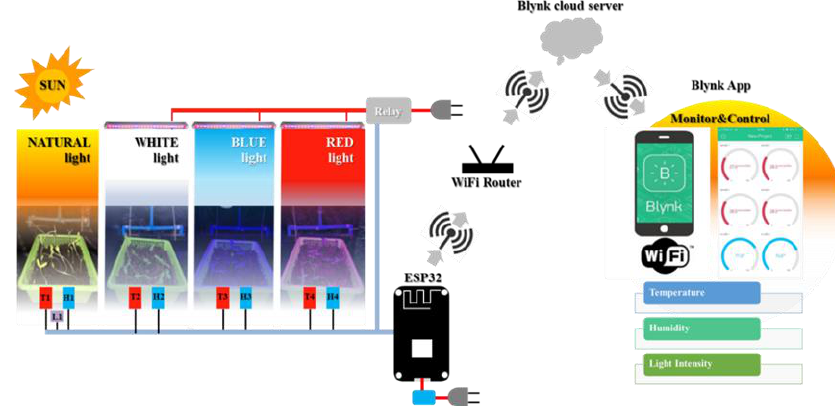
Figure 2. The proposed structure of the system architecture.